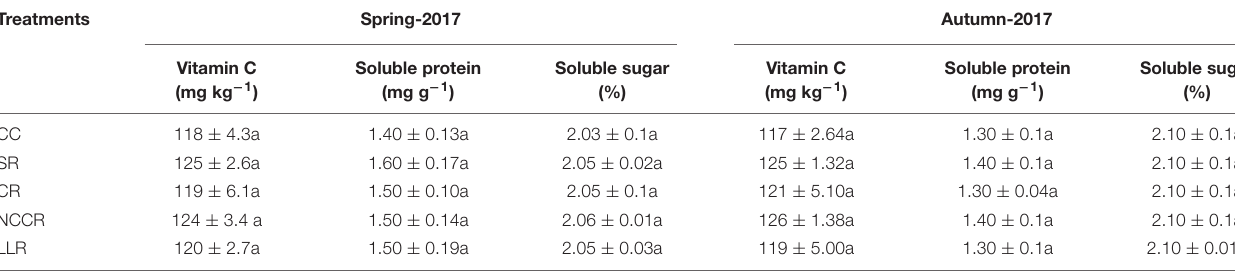
TABLE 2 | Cucumber fruits quality indices under different cropping treatments (Means ± SE, n = 3). Treatments